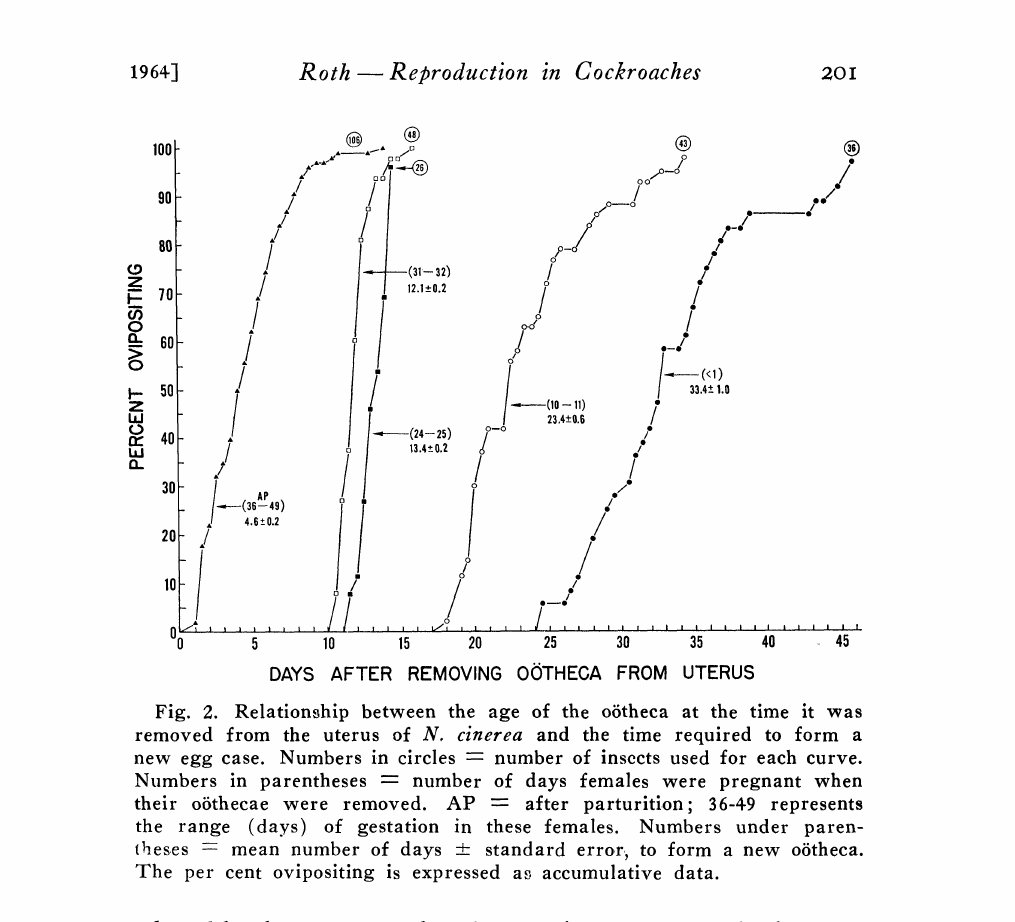
Fig, 2. Relationship between the age of the o$theca at the time it was removed from the uterus of No cinerea and the time required to form a new egg case. Numbers in circles number of insects used for each curve. Numbers in parentheses number of days females were pregnant when their o6thecae were removed. AP after parturition; 36-49 represents the range (days) of’ gestation in these females. Numbers under paren- theses mean number of days _+ standard erro.r, to form a new o6theca. The per cent ovipositing is expressed as accumulative